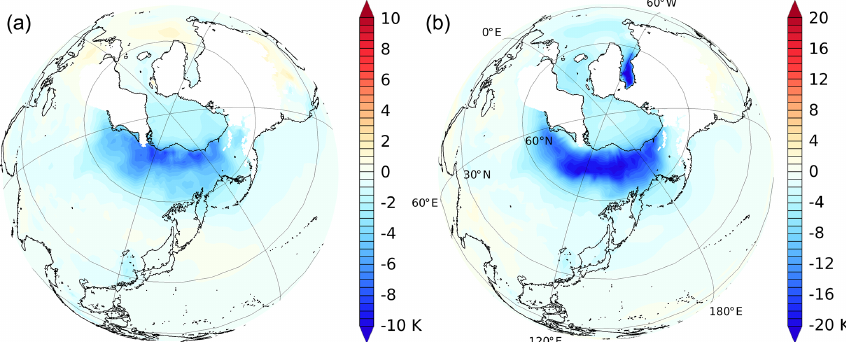
Figure 7. JJA LGM temperature anomalies showing the impact of introducing vegetation–climate feedbacks. Results are shown as LGM–PI anomalies for CAM4 (a) LGM_CAM4_Veg – LGM_CAM4_noVeg and CAM5 (b) LGM_CAM5_Veg – LGM_CAM5_noVeg. Regions covered by continental ice sheets during the LGM have been masked out. The LGM coastlines are given in black. Note the different scaling used for the two panels.